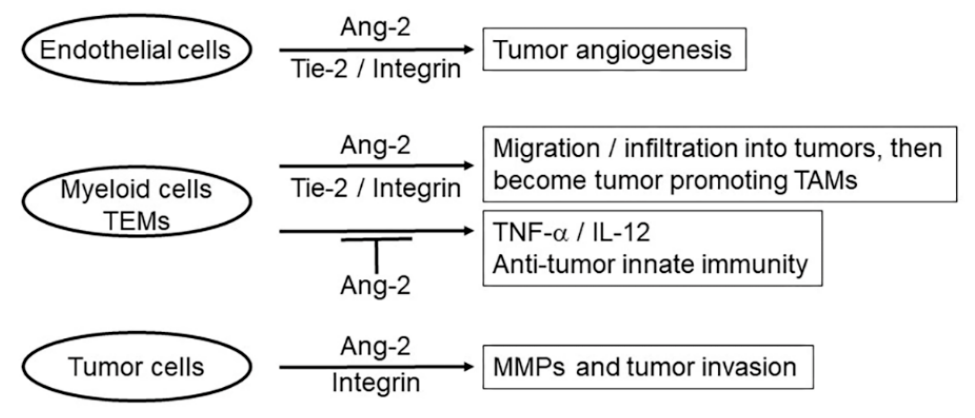
Figure2. Ang-2contributestocancerdevelopmentthroughmultiplemechanisms. Actingonendothelial Figure 2. Ang-2 contributes to cancer development through multiple mechanisms. Acting on endothelial cells through Tie-2 / integrin signaling, Ang-2 promotes tumor angiogenesis. Acting on myeloid cells through Tie-2/integrin signaling, Ang-2 promotes tumor angiogenesis. Acting on myeloid cells including TEMs through Tie-2 and integrin signaling, Ang-2 induces chemotaxis and their migration into tumors, which subsequently become tumor-promoting TAMs. Ang-2 also blocks production of TNF- α and IL-12 from the myeloid cells to undermine their anti-tumor activity. Ang-2 can also act on tumor cells through integrin signaling, inducing expression of MMPs to promote tumor invasion.